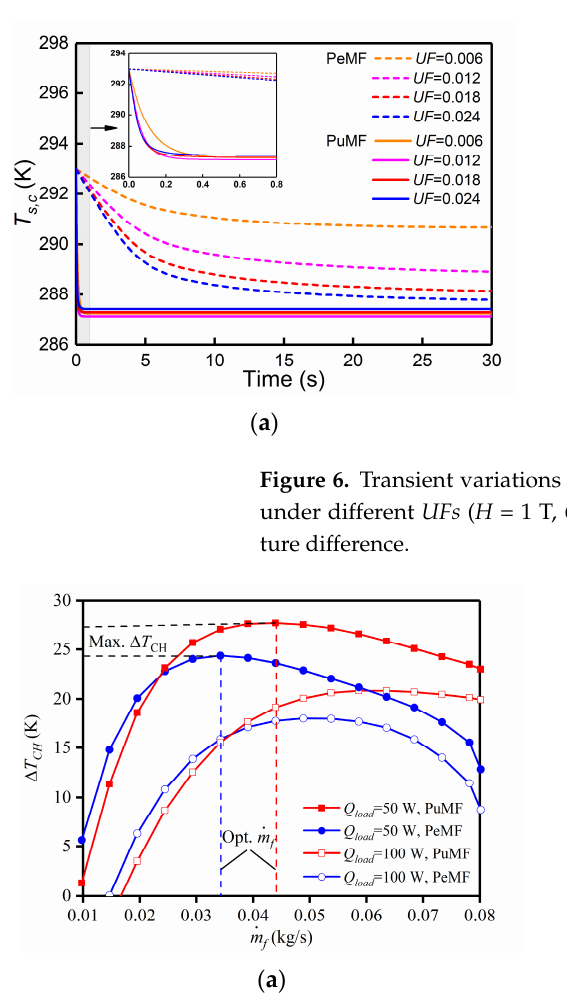
Figure 7. Steady ‐ state temperature difference Δ T CH and cooling capacity 𝑄 (cid:3030) = 1 T, T h = T i = 293 K). ( a ) Temperature difference; ( b ) cooling capacity.